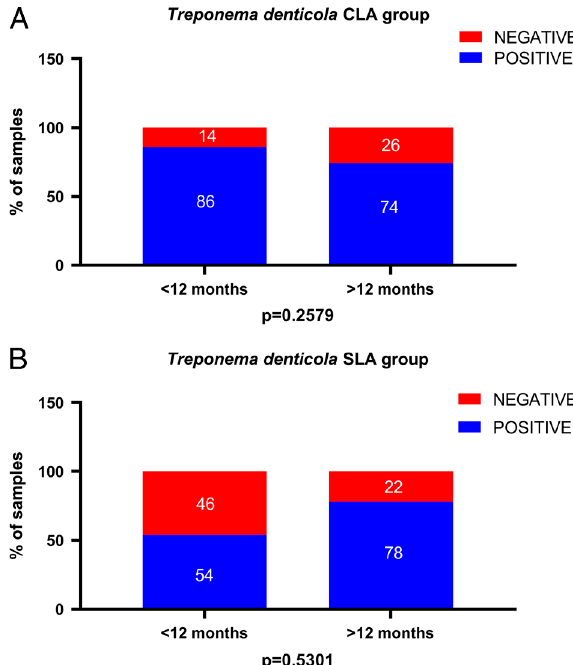
Figure 7. Differences between groups according to time of treatment. T. denticola has greater presence in CLA and SLA after 12 months of